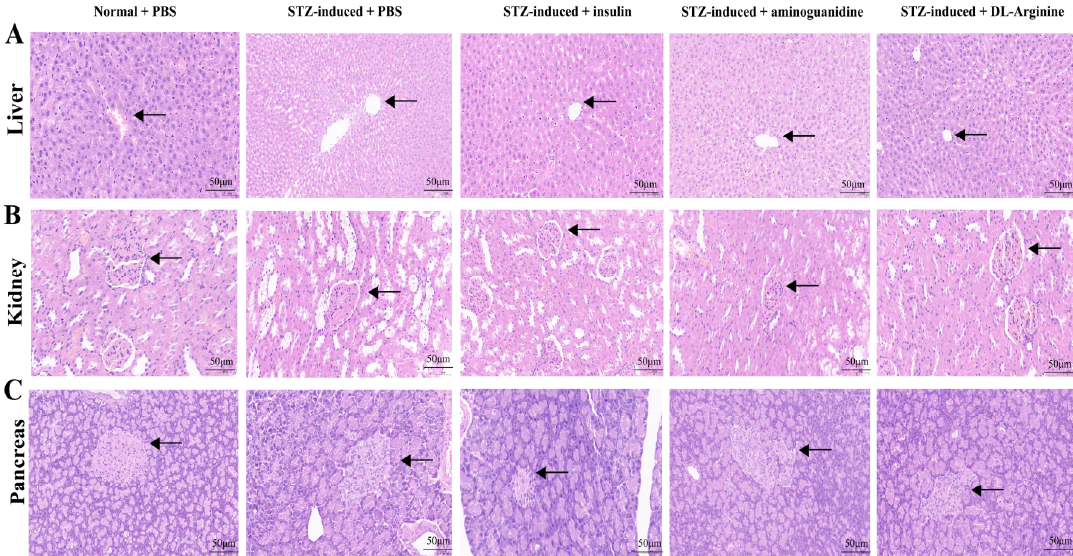
Figure 11. HE sections of the liver, kidney, and pancreas in different treatment groups of rats. ( A ) HE staining was used to detect the degree of injury and recovery in the liver sections. The arrow refers to the distribution of lipid droplet accumulation. ( B ) HE staining was used to detect the degree of injury and recovery in the kidney sections. The arrow refers to the distribution of lipid droplet accumulation glomeruli. ( C ) HE staining was used to detect the degree of injury and recovery in the pancreatic sections. The arrow refers to the distribution of pancreatic islets. (Scale bar = 50 μm).